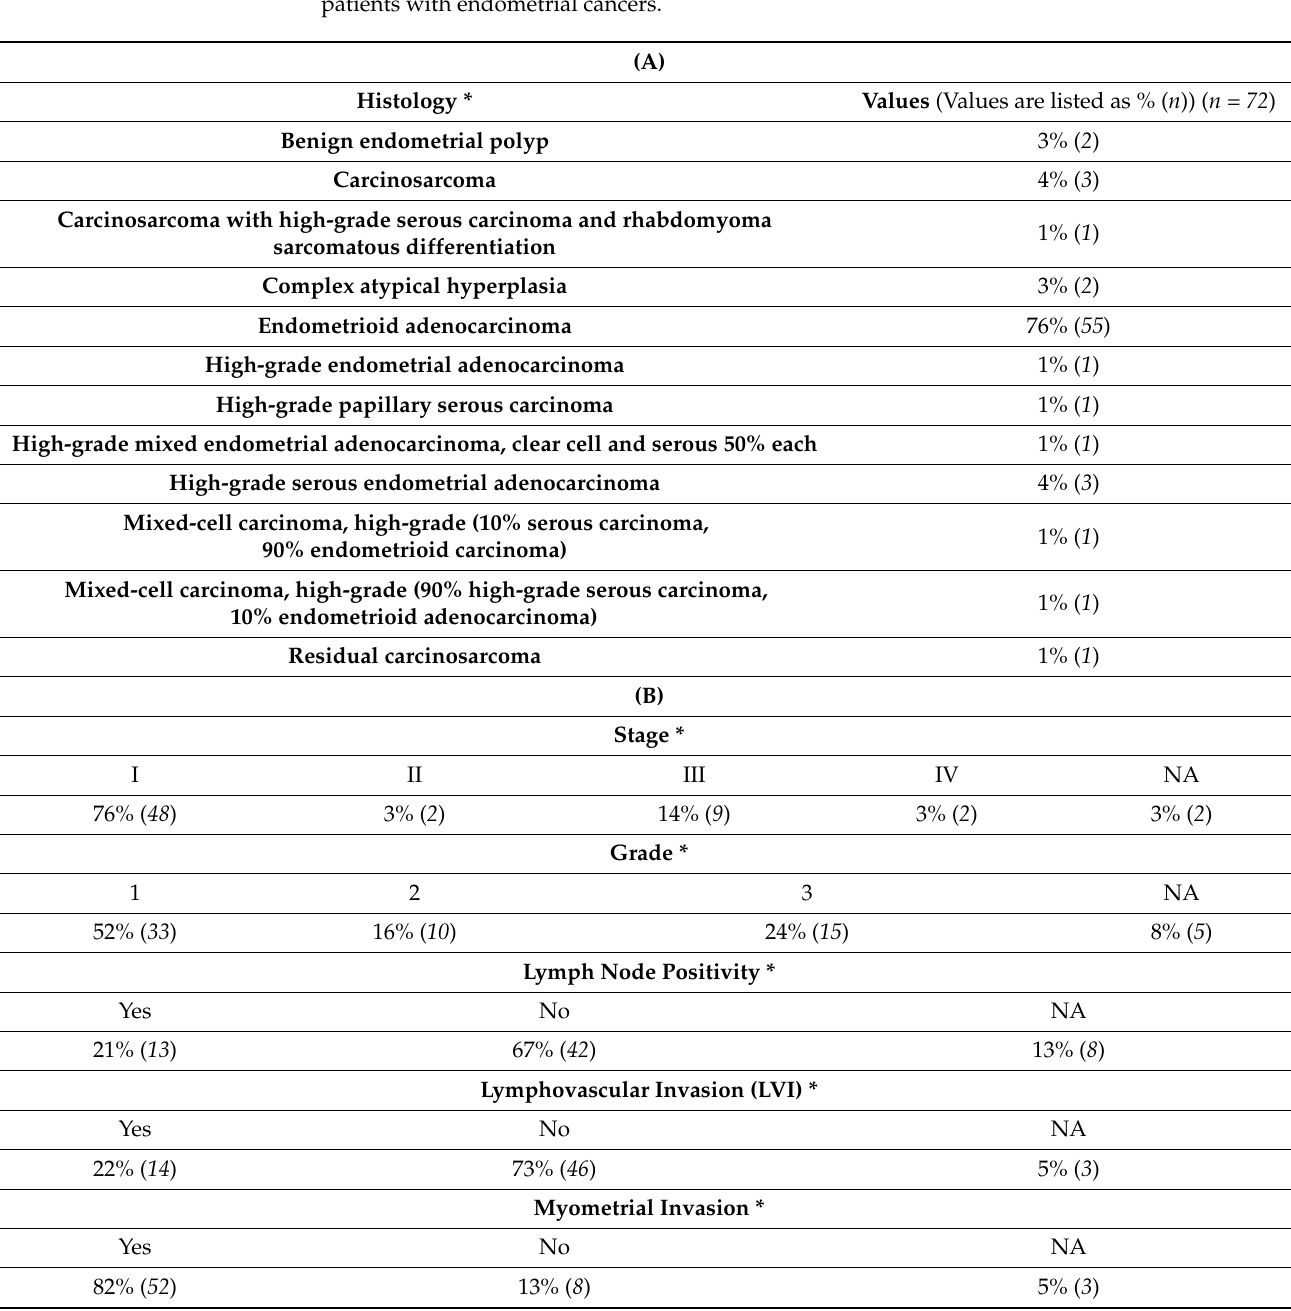
Table 2. ( A ) Histology of the tumors from the patients with endometrial cancers. ( B ) Stage, grade, lymph node positivity, lymphovascular invasion (lvi), and myometrial invasion of tumors from patients with endometrial